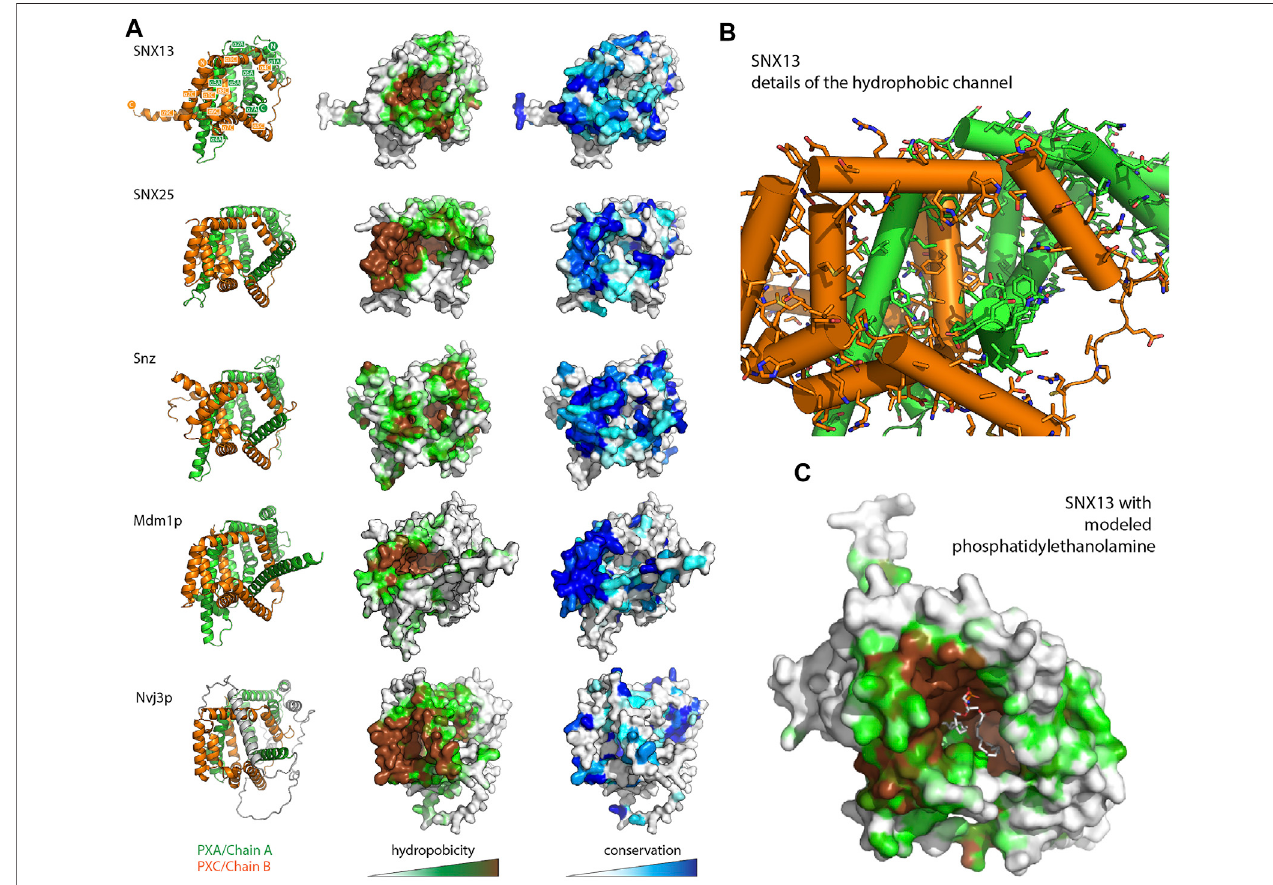
FIGURE 4 | The PXA-PXC structure forms a conserved hydrophobic cavity with potential for lipid binding. (A) The predicted structures of PXA-PXC domains from human SNX13 and SNX25, fl y Snz, and yeast Mdm1 and Nvj3 are shown in ribbon representation (left), surface coloured by hydrophobicity (middle), and sequence conservation (right). All PXA-PXC structures have a highly conserved hydrophobic tunnel. (B) Structure of PXA and PXC domains of SNX13 with sidechains of the putative lipid binding pocket shown. (C) The PXA and PXC domains of SNX13 is shown in close-up with its surface coloured for hydrophobicity as in (A) . A phosphatidylethanolamine lipid has been docked manually in the putative lipid binding pocket to give perspective on the dimensions of the channel.